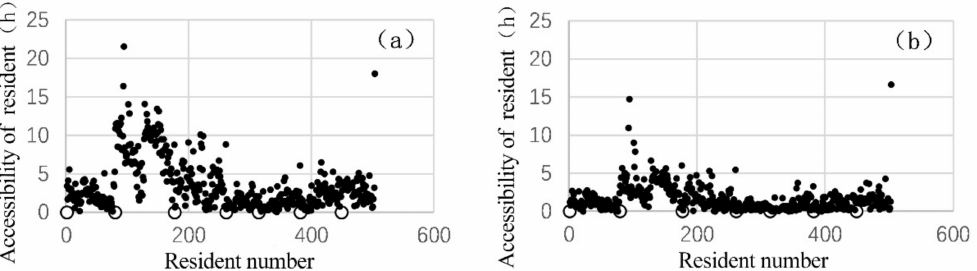
Figure 8. Traffic accessibility of villages in Nyingchi: ( a ) before traffic change; ( b ) after traffic